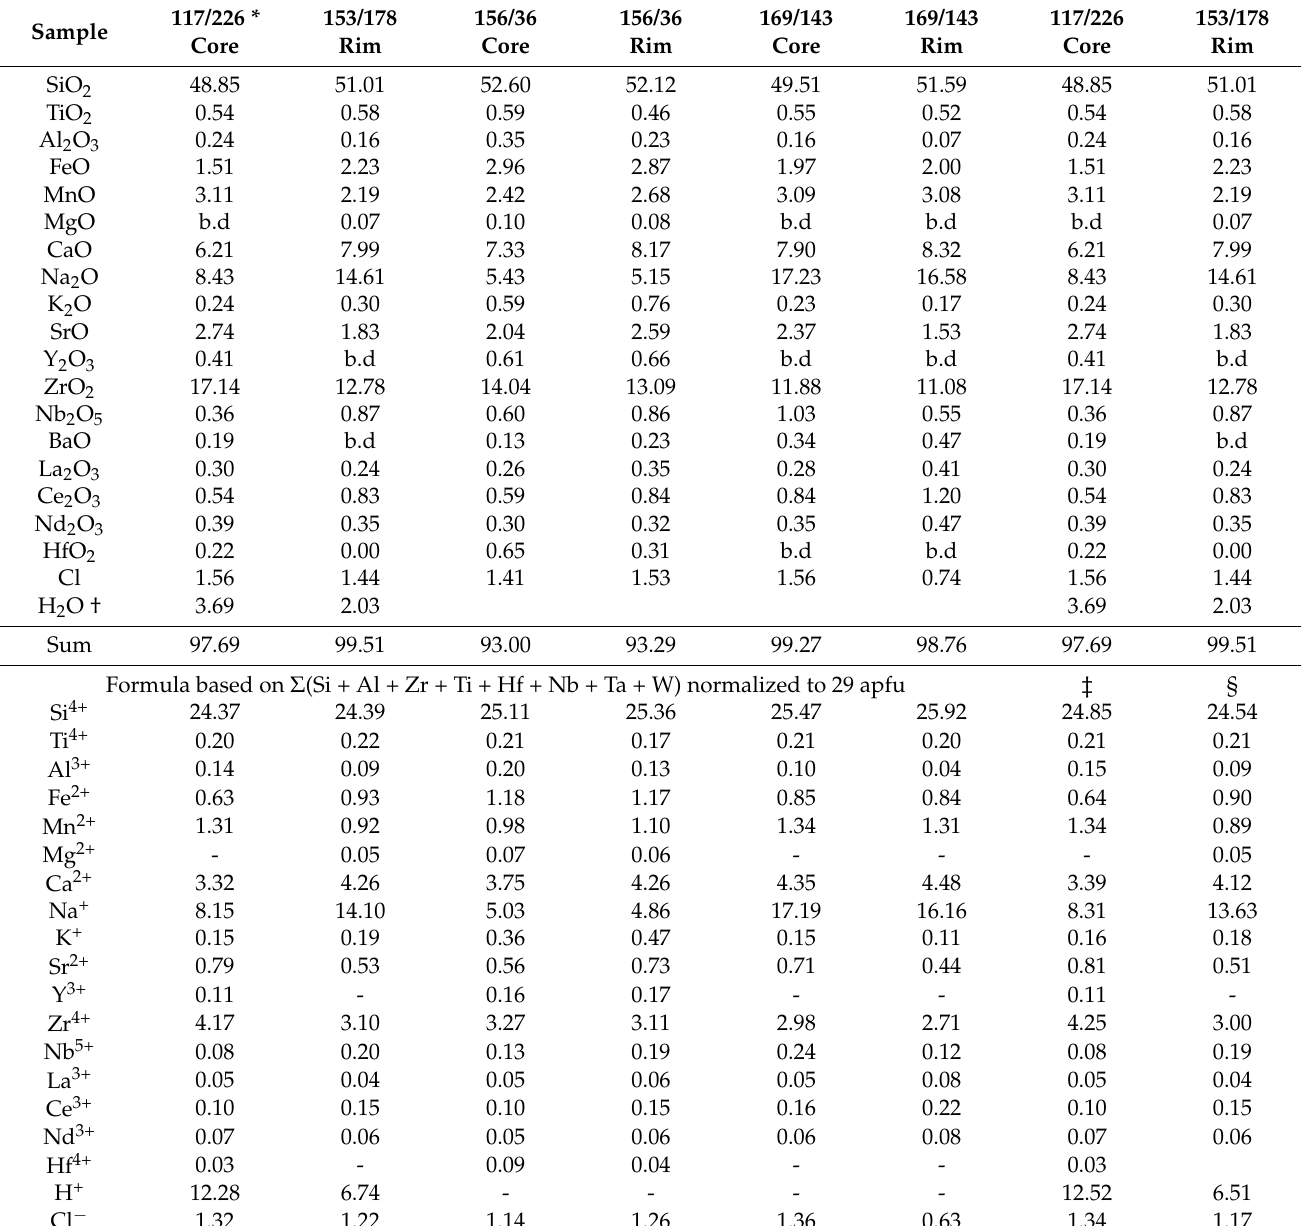
Table 1. Microprobe analyses of the EGMs studied by single-crystal XRD